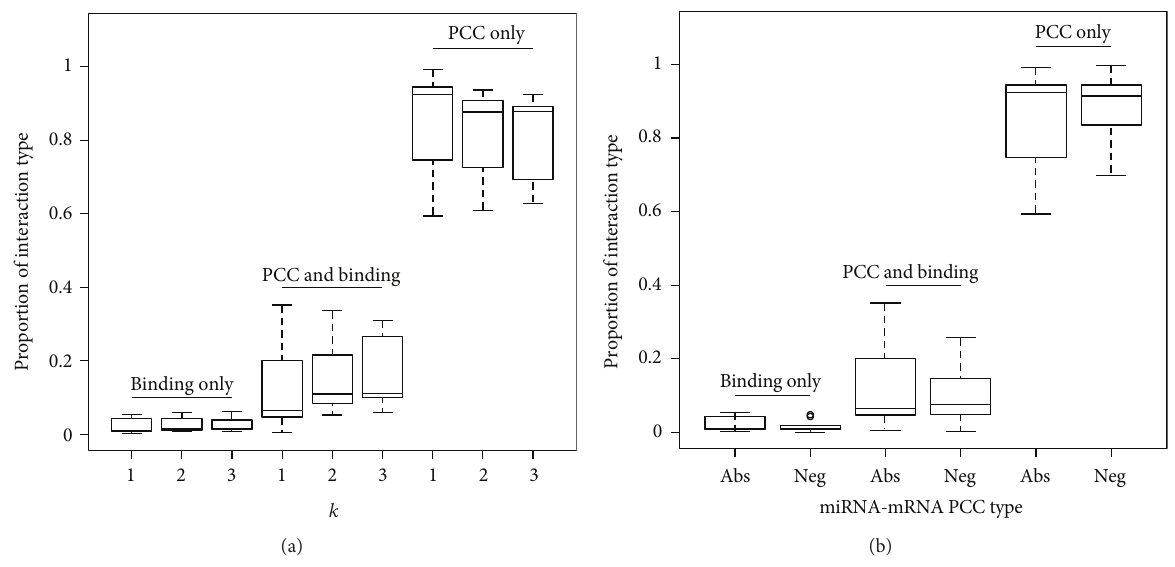
F 3: Boxplots of the proportion of three interaction types in the identi�ed 10 modules with de�nitions for the �tness score. (a) e three boxplots in each type represent the results for ( in each type represent the results using (1) both positive and negative microRNA-mRNA PCCs and (2) negative microRNA-mRNA PCCs,